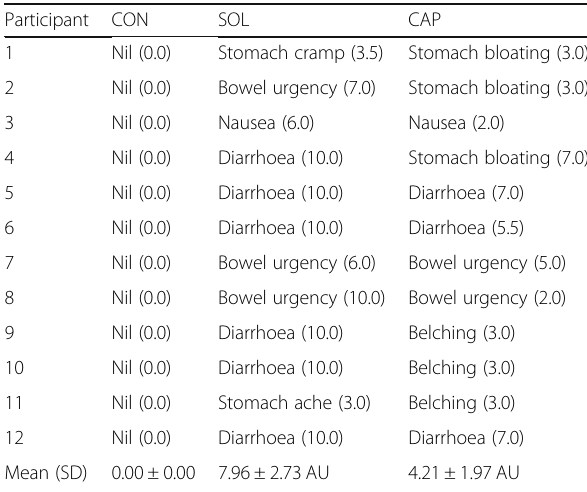
Table 1 The most severe individual GI symptom reported during any trial. Symptom scores are displayed in parenthesis and are expressed as arbitrary units (AU)